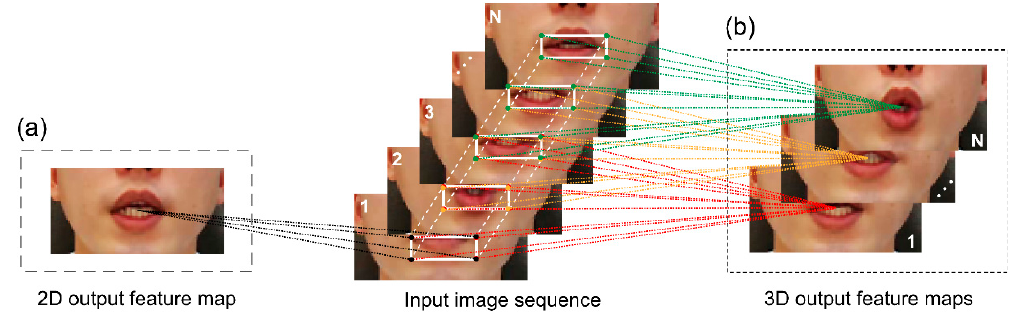
Figure 3. Detailed schematic of the proposed visual speech recognition module. Figure 4. ( a ) Two-dimensional convolution operation. ( b ) Three-dimensional convolution opera-